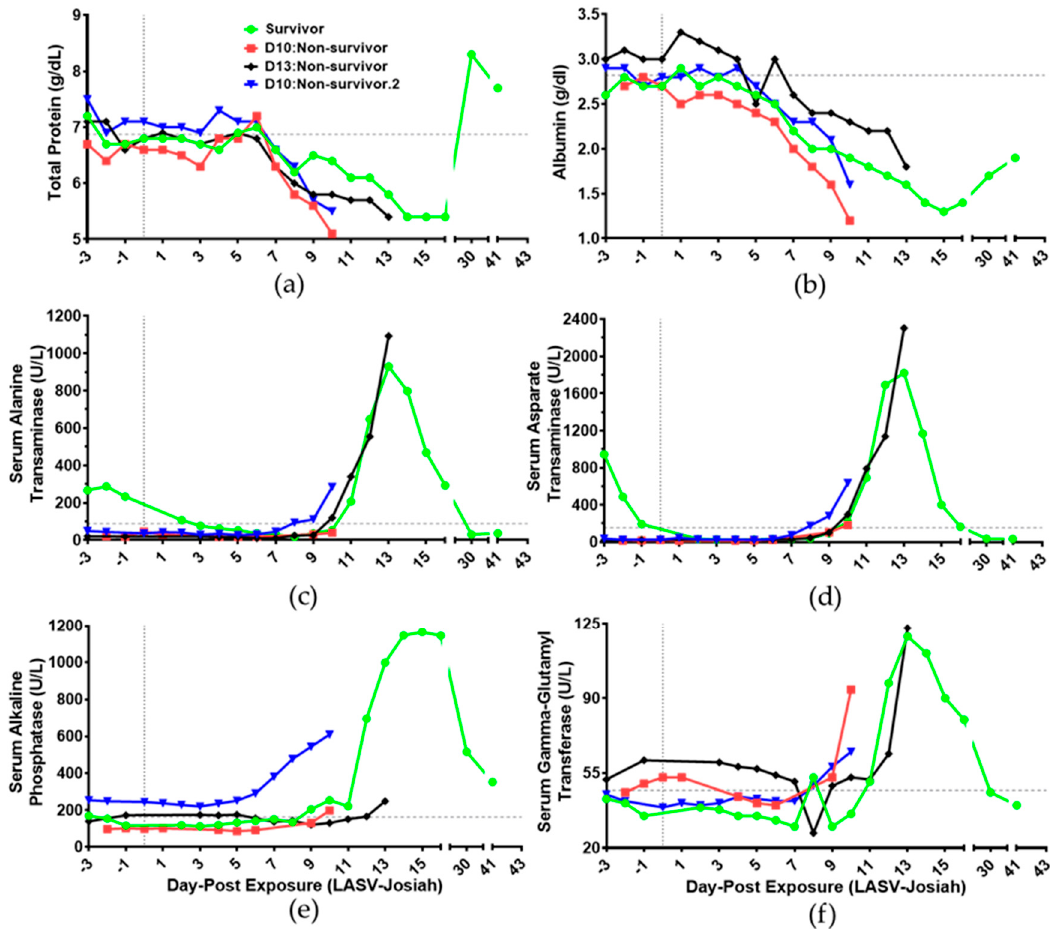
Figure 5. Time course of plasma proteins and liver function enzymes of Lassa virus-challenged cynomolgus macaques. Detection of ( a ) total protein and ( b ) albumin in plasma of whole blood using Piccolo chemistry. Serum levels of ( c ) alanine transaminase, ( d ) aspartate transaminase, ( e ) alkaline phosphatase, and ( f ) gamma-glutamyl transferase were detected in serum using Piccolo chemistry. ( ● Survivor) ( ■ D10:Non-survivor) ( ♦ D13:Non-survivor) ( ▼ D10:Non-survivor.2) (Vertical grey dotted line: DPE 0) Grey dashed line is average relative to each animal for DPE -3 to DPE 0.